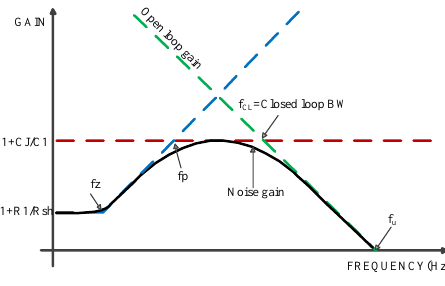
Figure 6. Generalized noise gain bode plot.